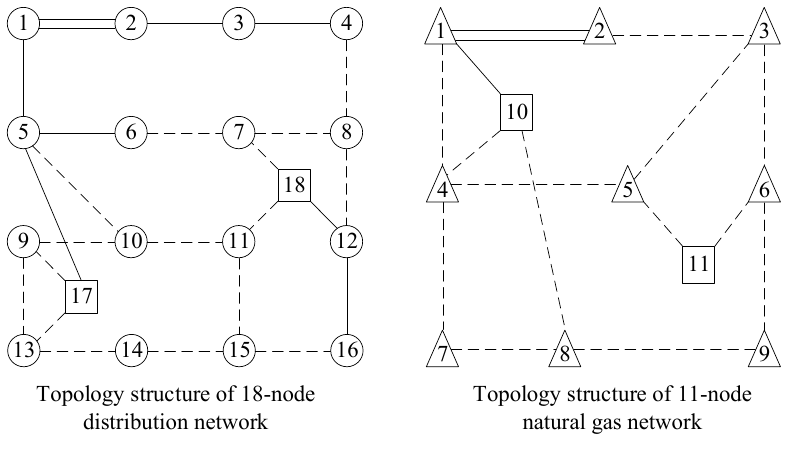
Figure 7. Topology of IES network.